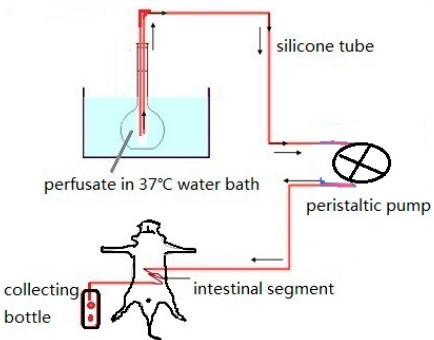
Figure 8. Single pass perfusion.